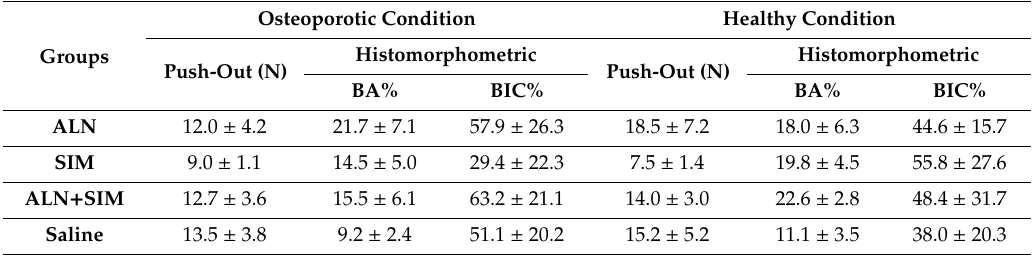
Table 2. Mean values of measured variables in di ff erent study groups and drug treatment protocols.